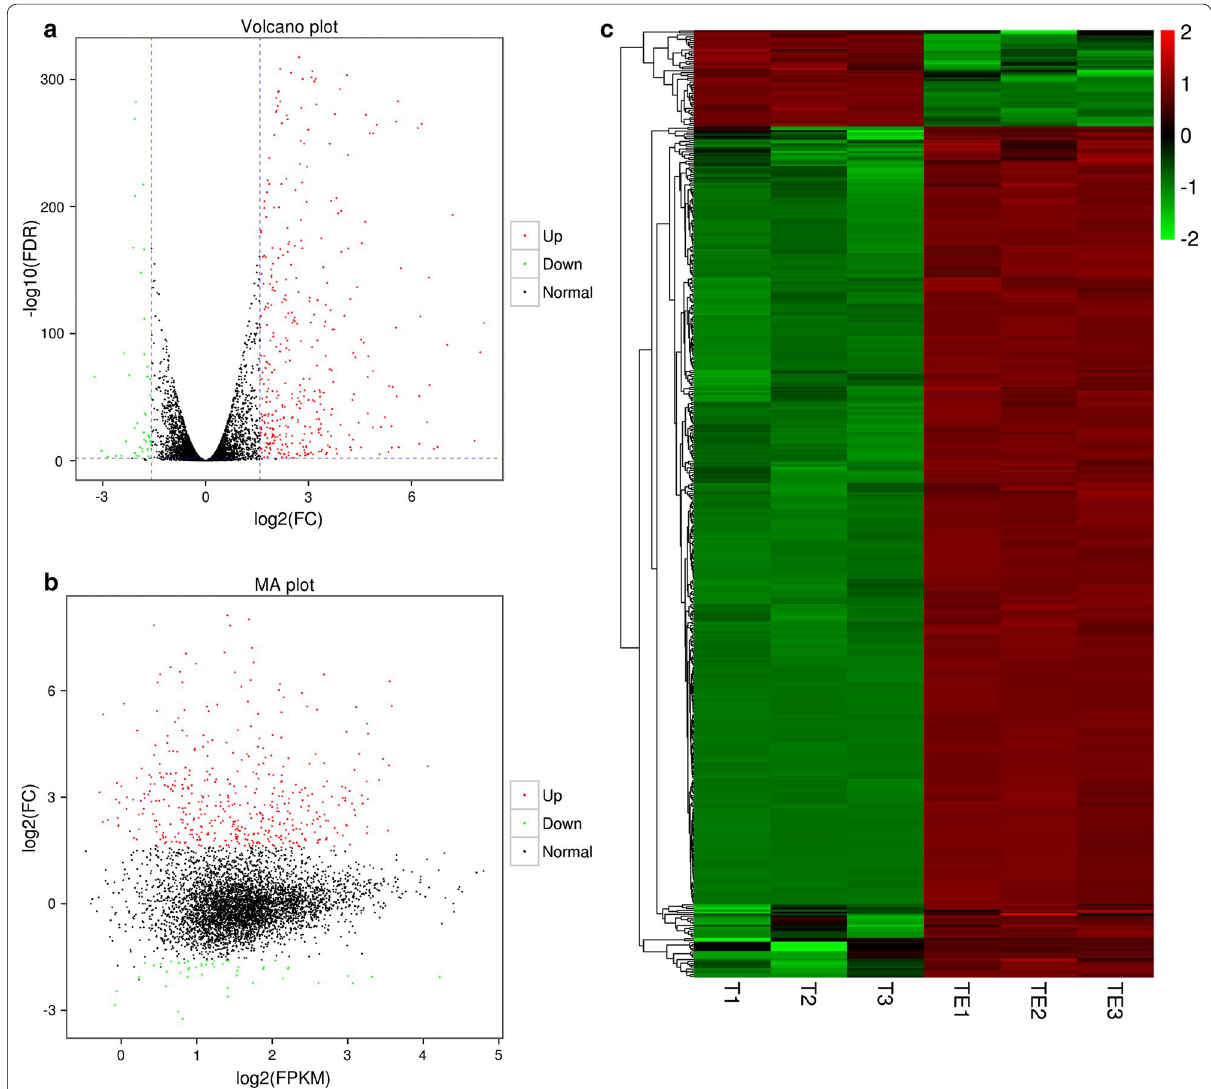
Fig. 3 Distribution of DEGs in ethanol-stressed and control I. orientalis . a Volcano plot showing all DEGs. Dashed lines indicate inclusion criteria for false discovery rate (FDR < 0.01; line at 2 on the y-axis) and Fold Change (FC > 3; line at ~ 1.6 on the x-axis). Red, more abundant in ethanol-stressed = cells; green, more abundant in control cells; black, does not meet inclusion criteria and assumed to be unchanged. b MA plot showing FC vs. FPKM for all DEGs. Colors are as in ( a ). c Heatmap showing all DEGs. Colors indicate expression levels of